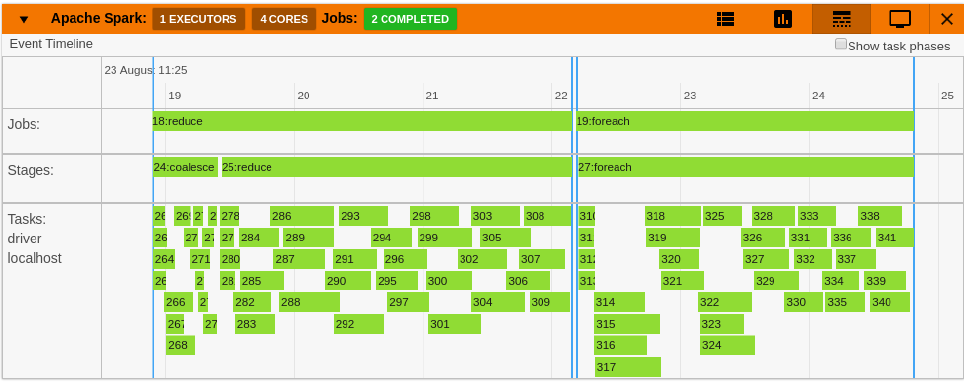
Figure 5: Visualisation of Spark Application decomposition Figure 2: Spark Configuration Figure 3 : Configuration Bundle